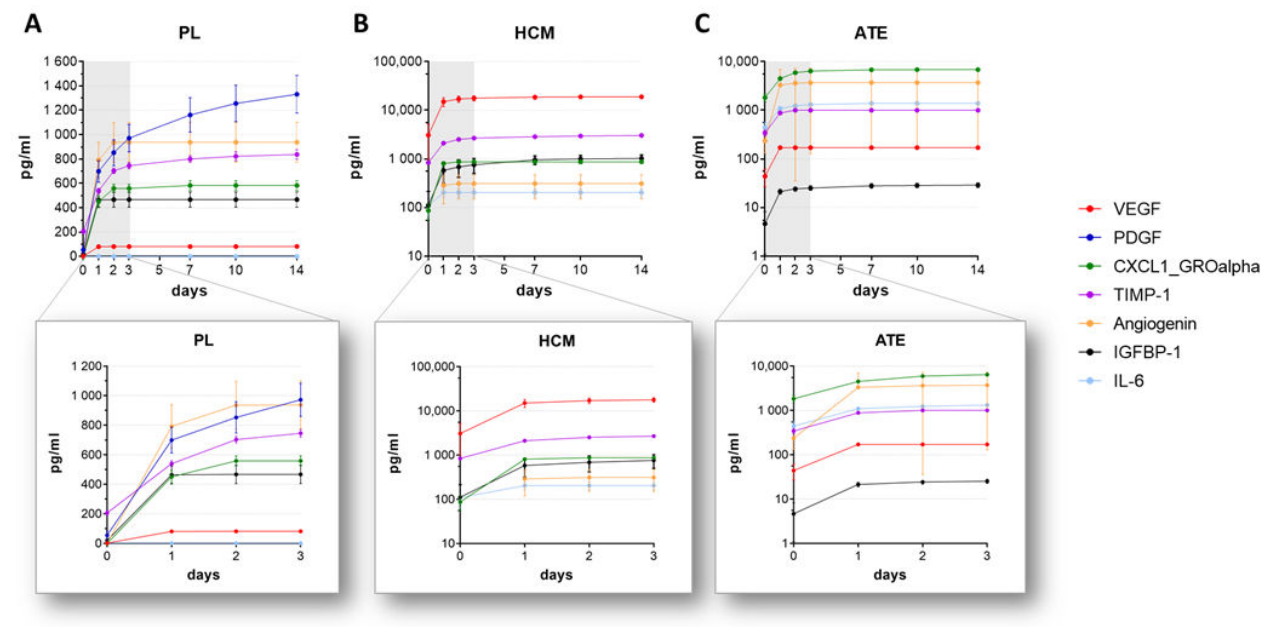
Figure 2. Growth factor and cytokine release from ( A ) PL-, ( B ) HCM- and ( C ) ATE-functionalized mineralized collagen scaffolds over 14 days (upper row) and detailed over 3 days (lower row). Different scaling of the Y-axis was used to ensure suitable data presentation for each factor mixture (mean ± SD, n = 3).